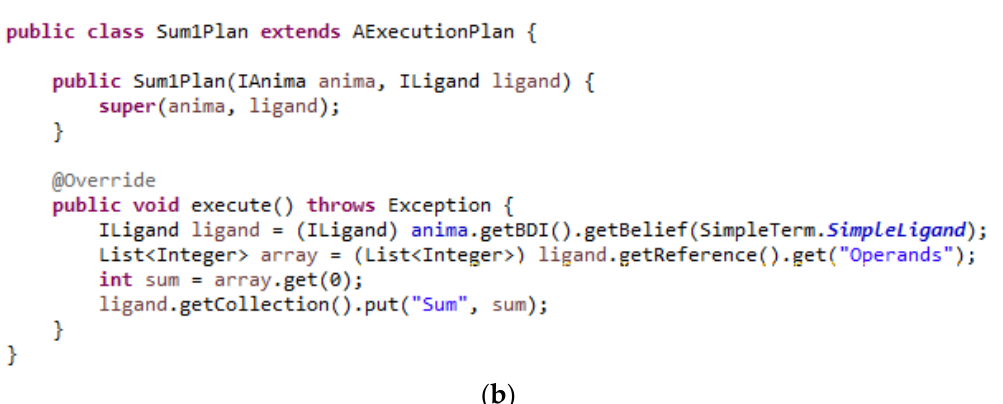
Figure 9. The plan is for a simple addition example: ( a ) This plan handles multiple input values; ( b ) This plan deals with the case of 1 input value.